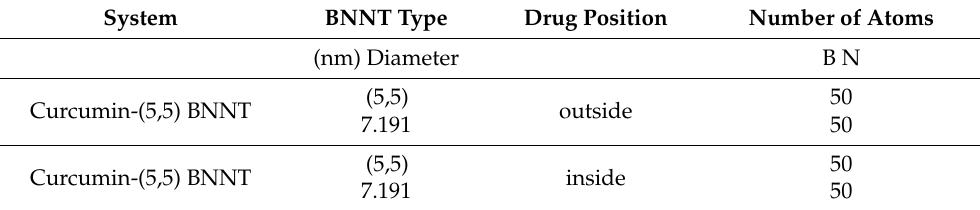
Table 3. The simulated